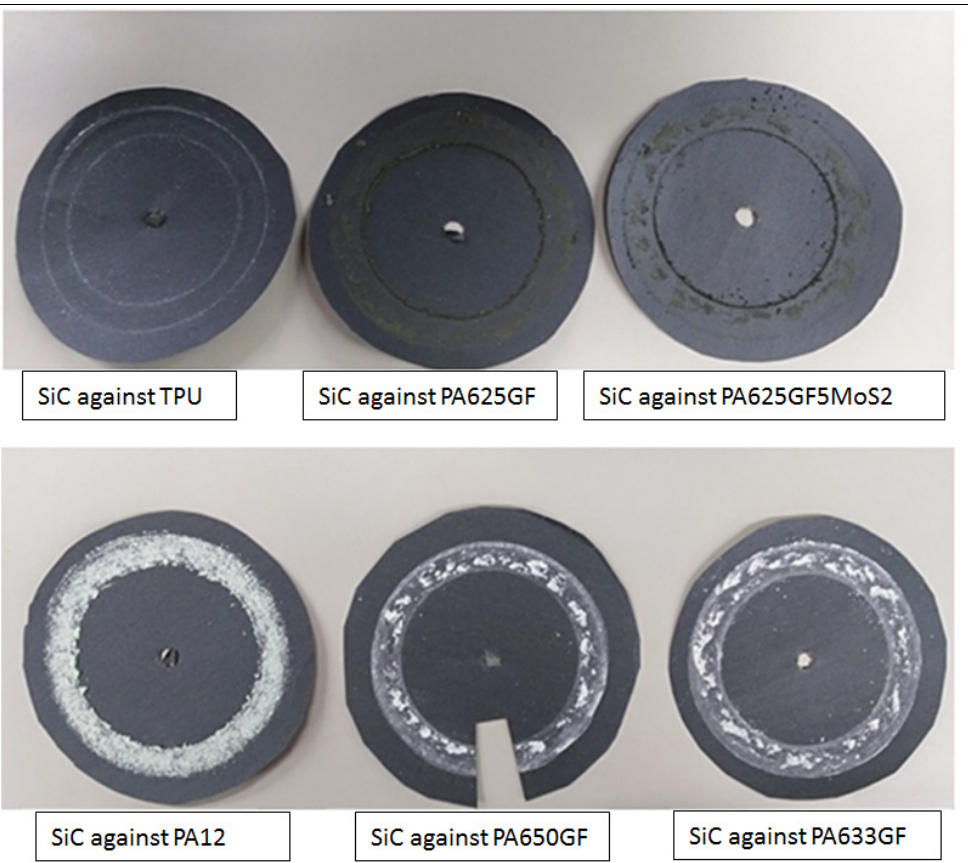
Figure 11. Wear track on SiC grinding papers counter-face after conducting the wear test .